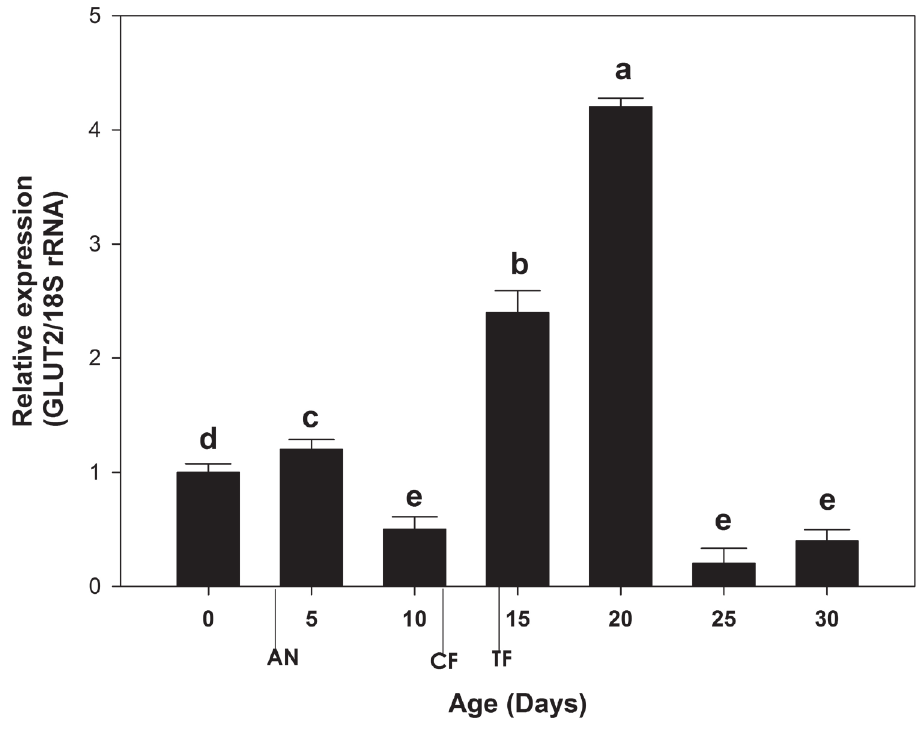
FIGURE 5 | Relative expression of glut2 during the early ontogeny of Petenia splendida . Lowercase letters indicate significant differences in the expression of glut2 as a function of developmental time (p < 0.05). AN: Artemia nauplii (3–10 dph), CF: cofeeding (Artemia nauplii